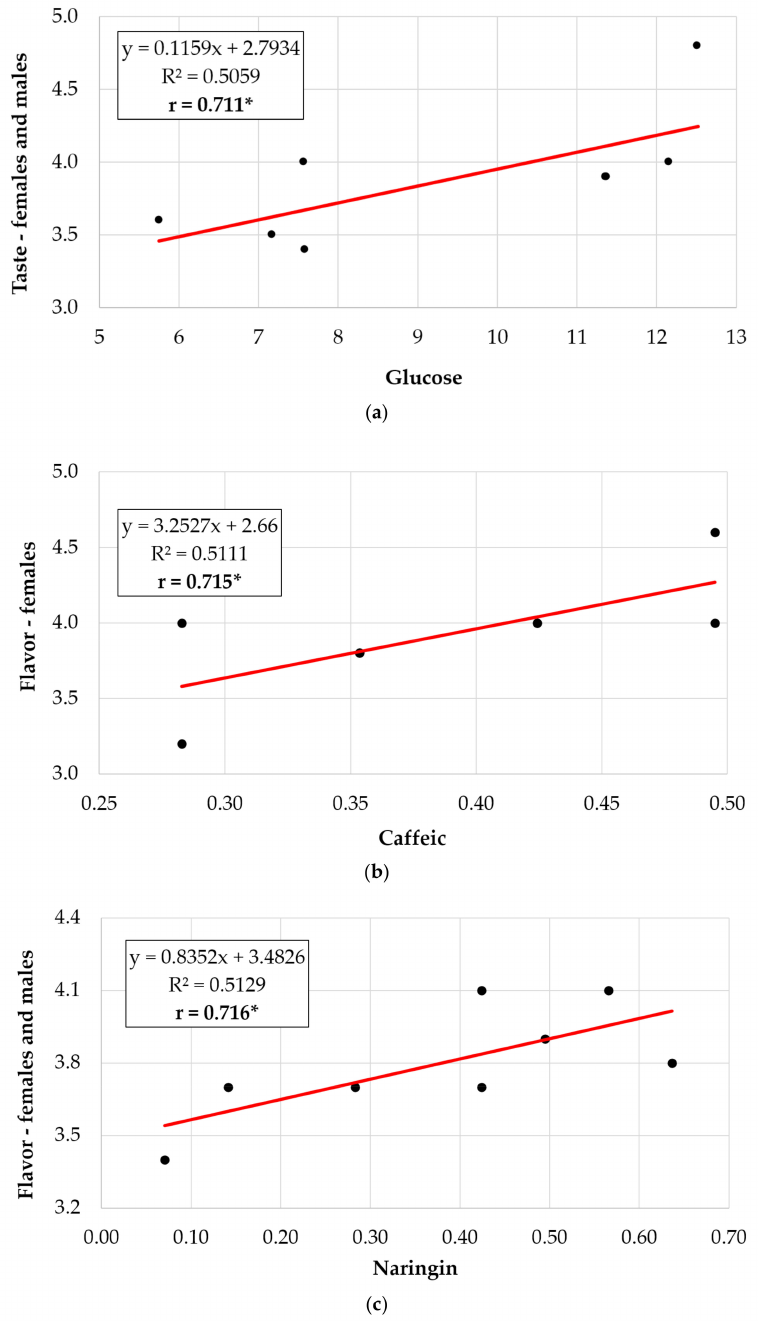
Figure 3. ( a – c ) Relations between the chemical contents of the tomatoes and notes on tasting, separately by female and male tasters, and all tasters, as a whole, both male and female tasters, analyzed by regression equations, coefficients of determination and correlation (only the figures for the Pearson correlations with ‘r’ value significant for the 0.05 level are